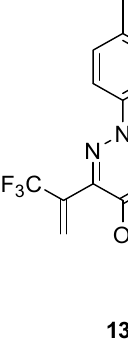
Figure 35. α -Truxillic acid derivative with (–)-borneol fragment. Figure 36. Ester derivative of natural occurring (–)-borneol with hydrazinylidene group.